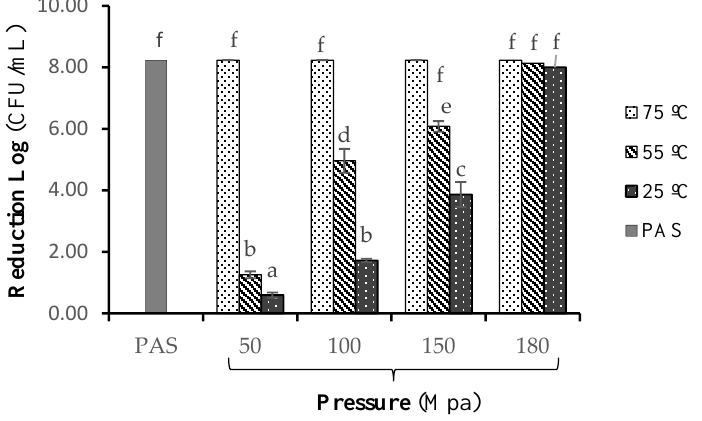
Figure 1. Inactivation of E. coli (CECT 434) (8.2 log CFU/mL) inoculated in Brazil nut beverage submitted to pasteurization (PAS) (63 °C, 20 min) and high-pressure homogenization process (HPH). Bars with different letters, lowercase in column or uppercase in row (day 0), are different ( p < 0.05).